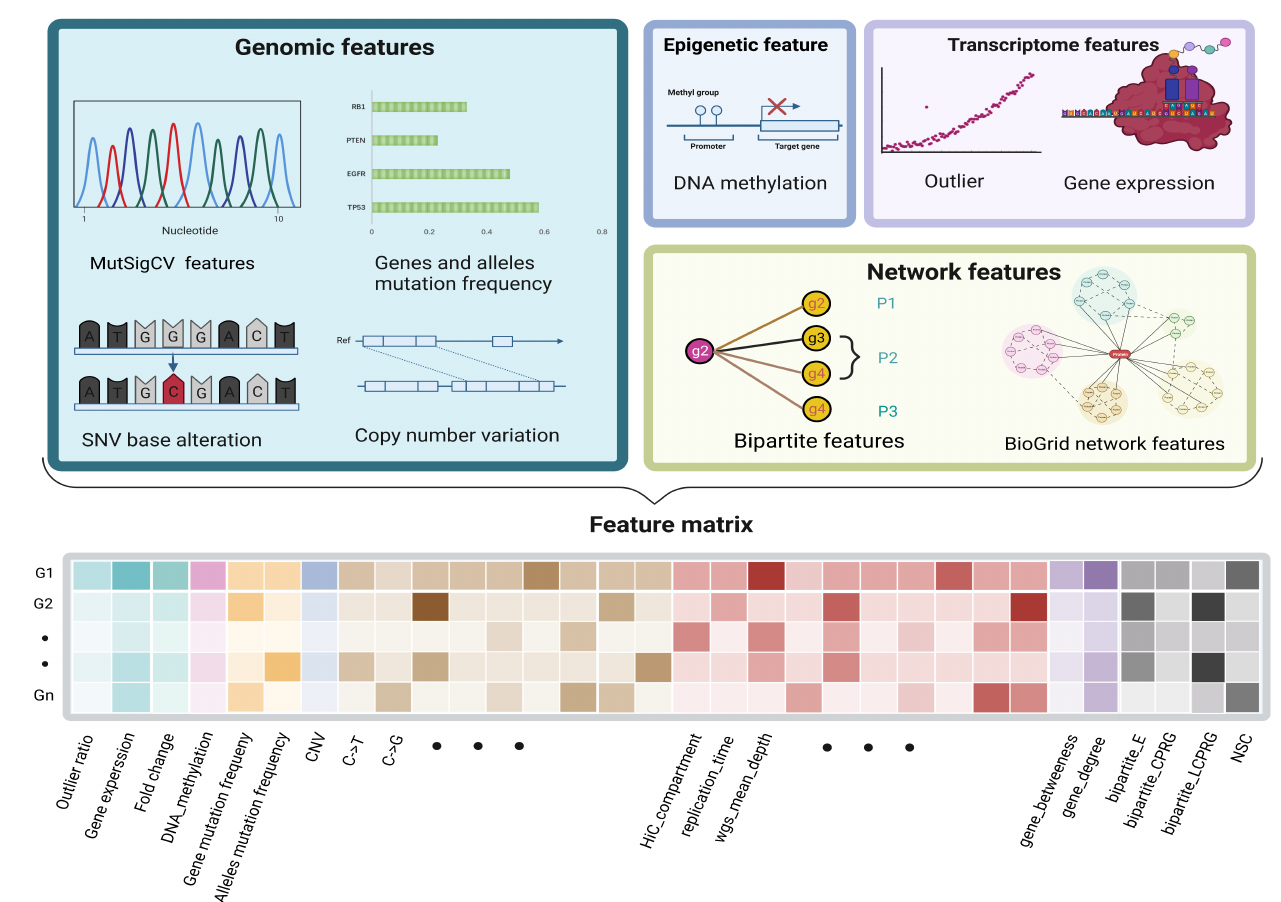
Figure 3. The characteristics of each gene. The attributes of a gene included the following four parts, 26 genomic features, 3 transcriptomic features, 1 epigenomic feature, and 6 network derived features from the bipartite graph and BioGrid network, which together formed a 1 × 36-dimension feature vector for each